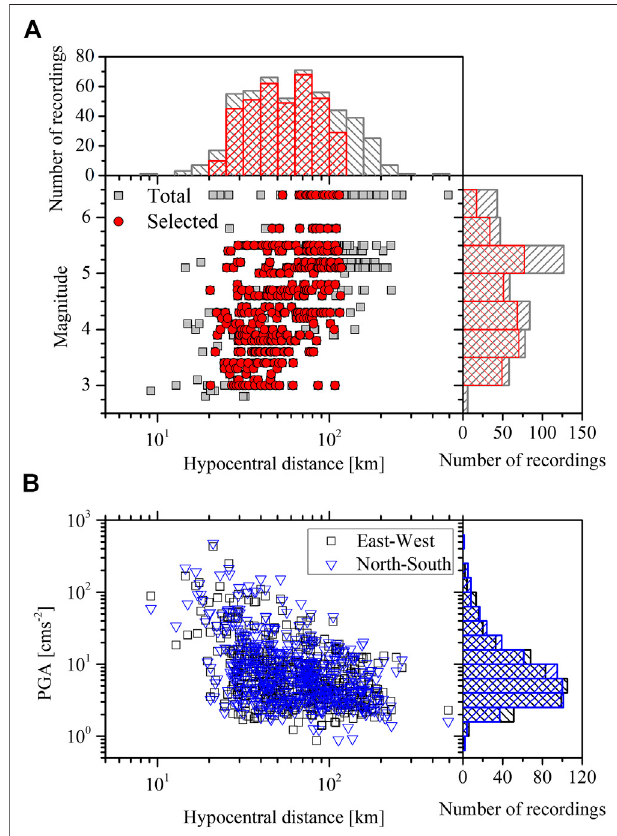
FIGURE 2 | (A) Hypocentral distance vs. magnitude for the total recordings collected in this region (squares) and the recordings selected for the spectral inversion analysis (circles). The histograms of the hypocentral distance and the magnitude of the total recordings and selected recordings are also plotted. (B) Peak ground accelerations (PGAs) of both horizontal components (east-west and north-south) for total recordings and the histograms of the horizontal